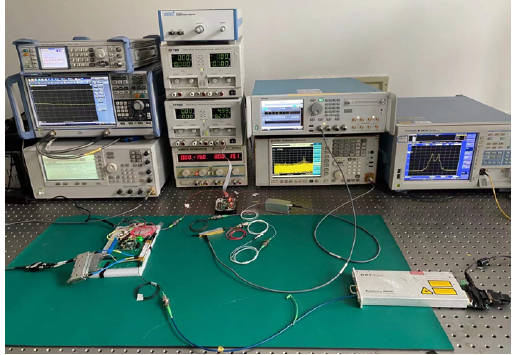
Figure 2. Experimental setup of the proposed phase-coded microwave signal generator.